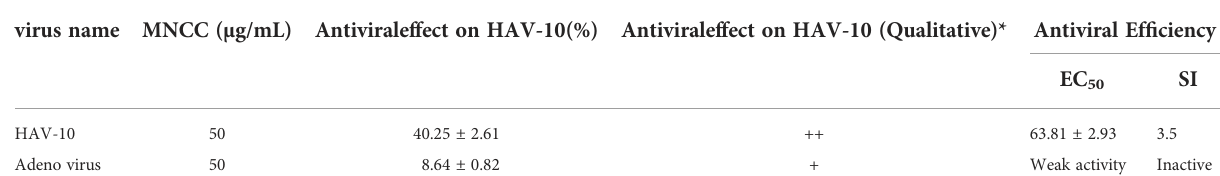
TABLE 1 The antiviral effects of PoSeNPS when tested at